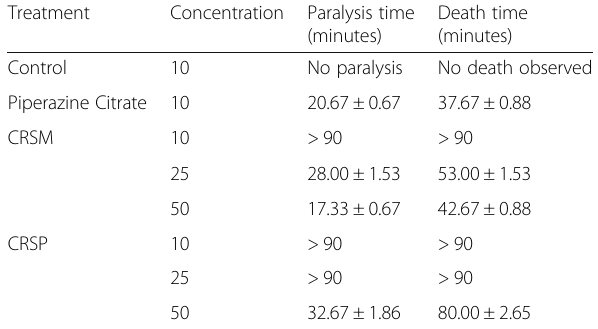
Table 4 Brine shrimp lethality of different extracts of C. renigera seed